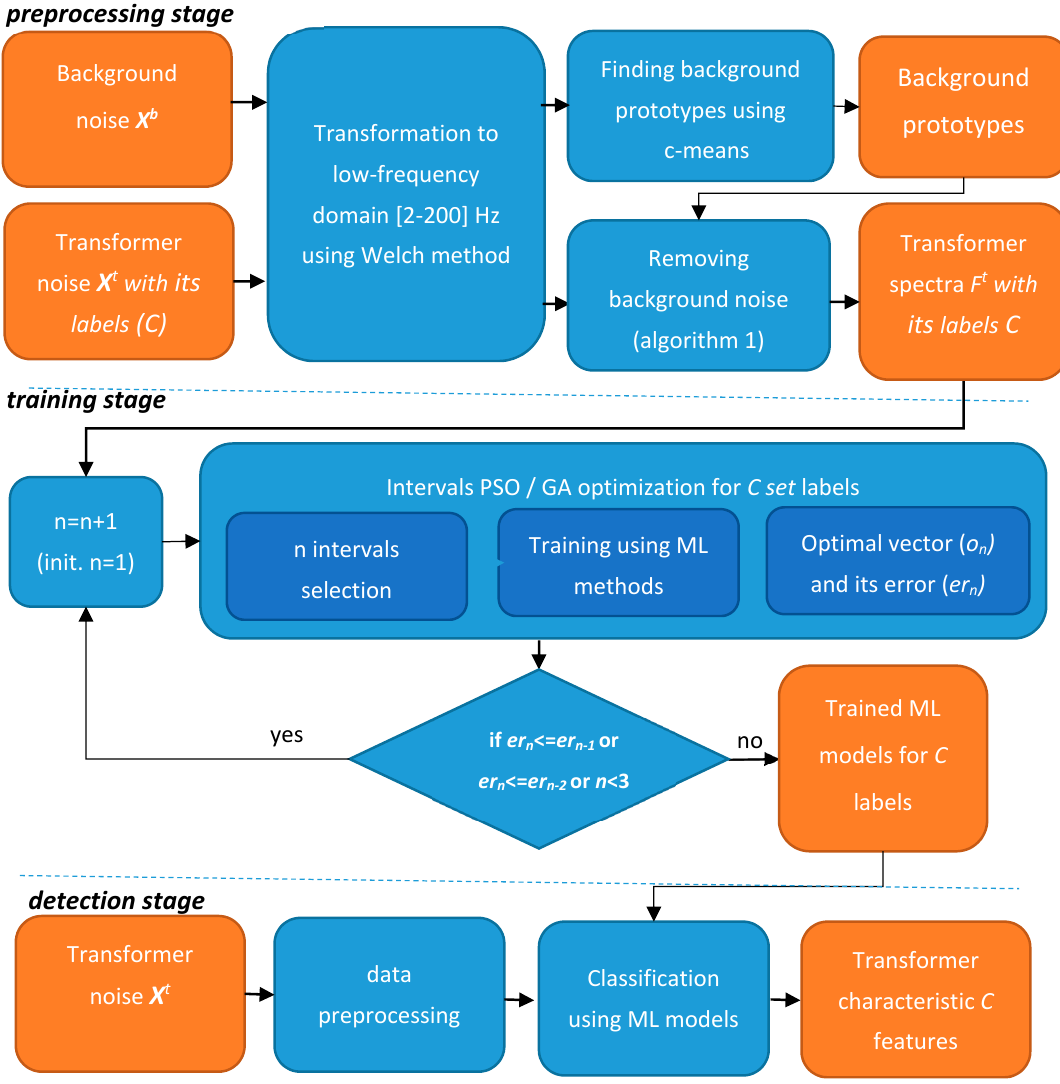
Figure 3. Proposed method for the detection of transformer parameters.